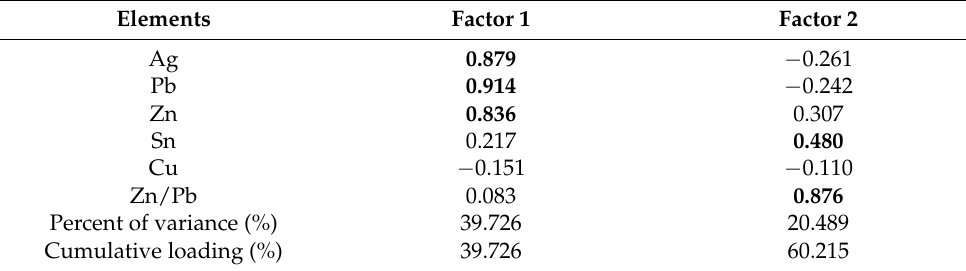
Figure 7. Factor analysis results. ( a ) Scree plot; ( b ) Factor score plot of samples (FAC 1 –FAC 2 ) and component arrows of elements. Table 3. Component matrix and total variance of factor